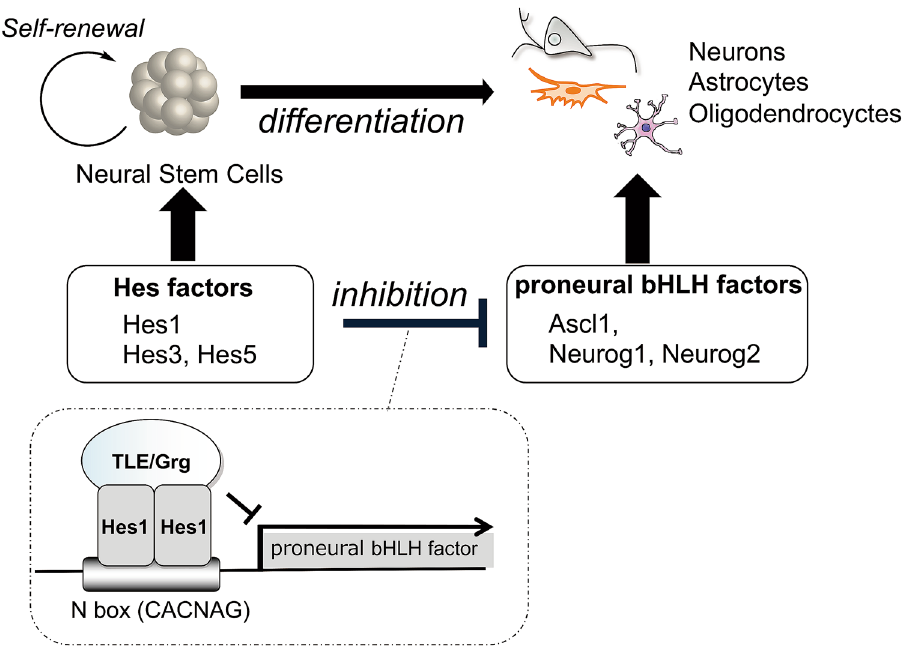
Figure 1. Neural stem cell differentiation and fate control by bHLH